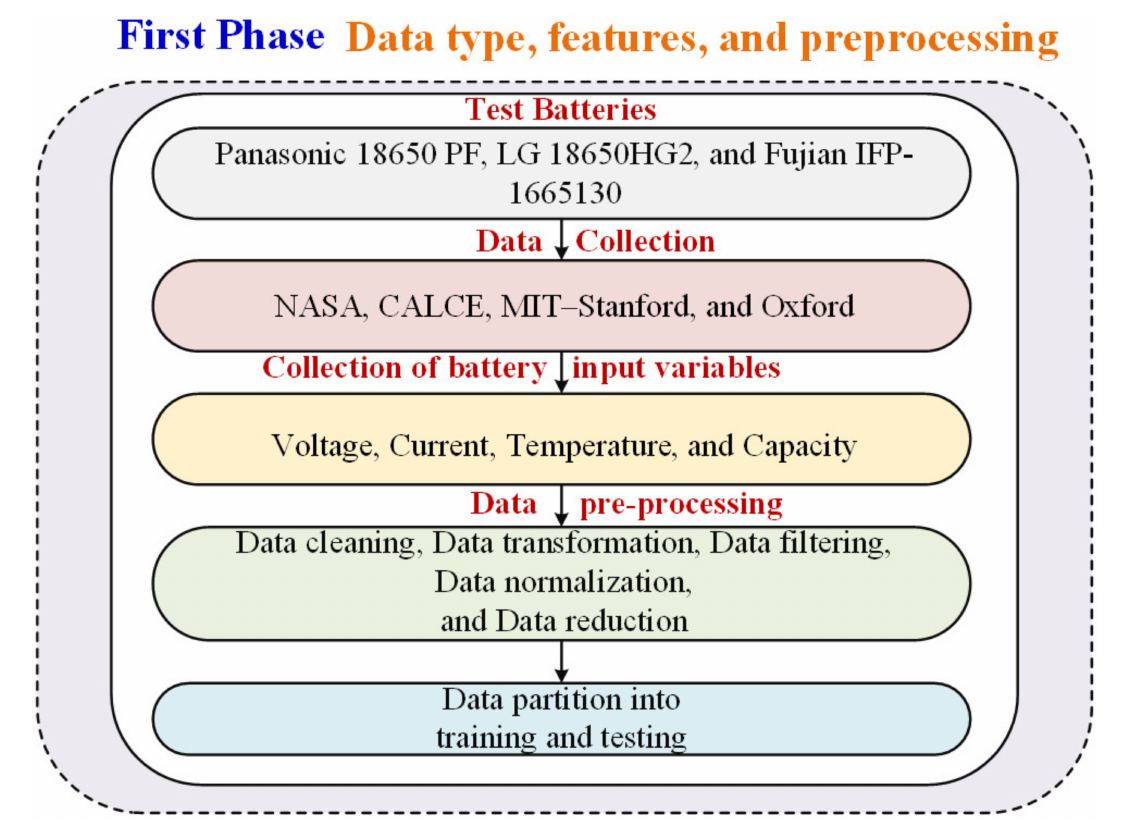
Figure 2. Data preparation and preprocessing for SOX estimation in automotive BMS.